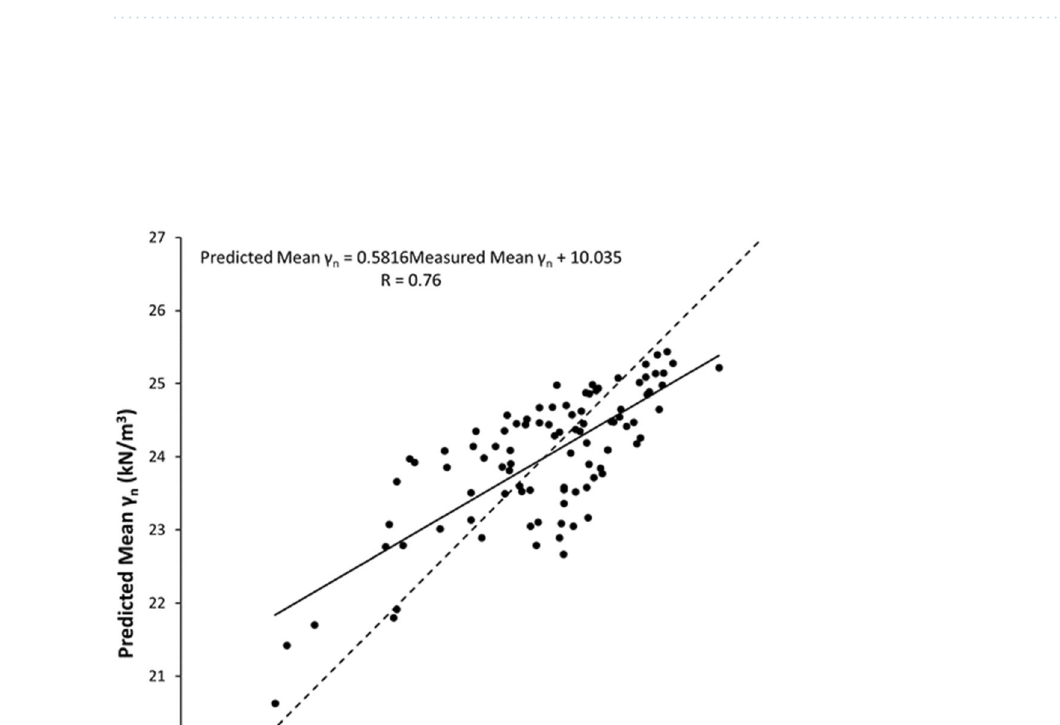
Figure 21. Cross-correlation of the measured and predicted values estimated from V p in terms of I d2 values of limestone.